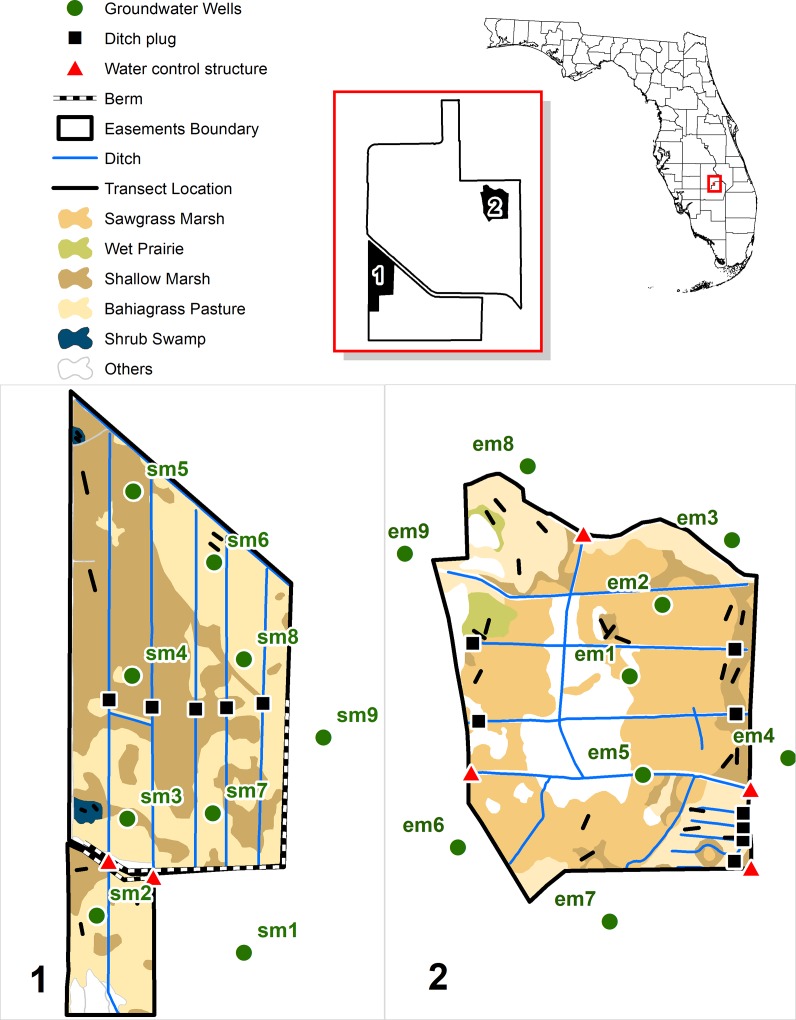
Location of the two conservation easements at Buck Island Ranch.Vegetation types and locations of the groundwater wells and vegetation transects are shown in the South Marsh (1) and the East Marsh (2).